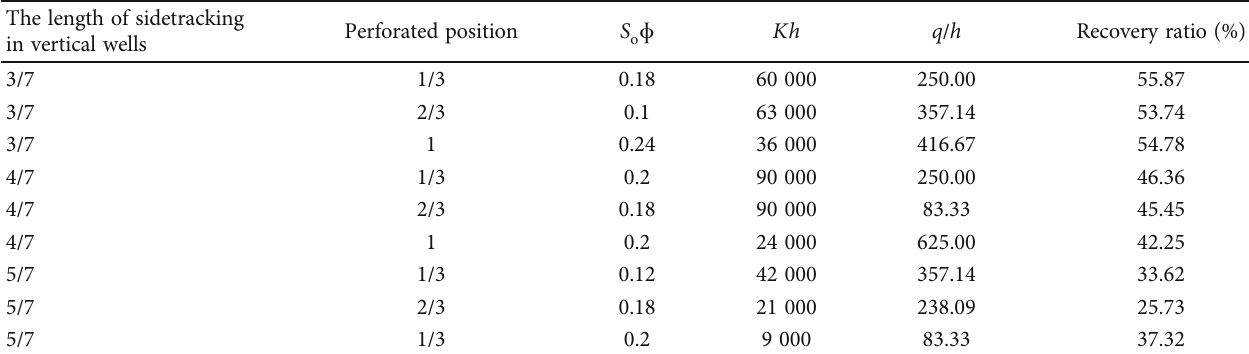
Figure 8: Recovery sensitivity analysis results. Among them, the meanings of the abbreviated letters in the fi gure are as follows: Ps: perforation location of gas injection well; So: oil saturation; Perm: permeability; h : reservoir thickness; Por: porosity; q : gas injection rate. Table 3: Recovery factor under di ff erent combination of main control